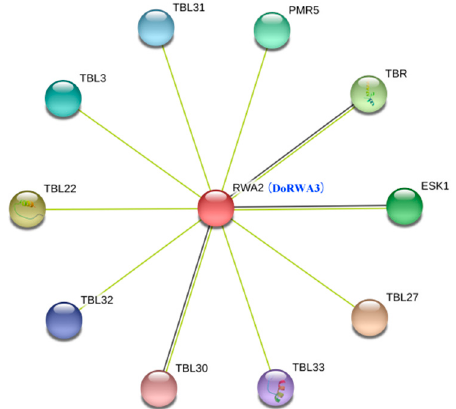
Figure 2. Protein–protein association networks of DoRWA3 using RWA2, a homologous Arabidopsis thaliana protein. Yellow lines represent “textmining” and black lines represent “co-expression”.